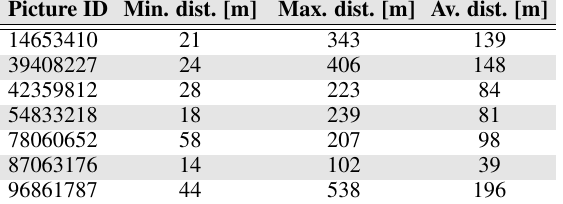
Table 2: Distances measured between recognisable landmarks found on an orthoimage and on rectified query images . Those images are also those presented in Figure 6.